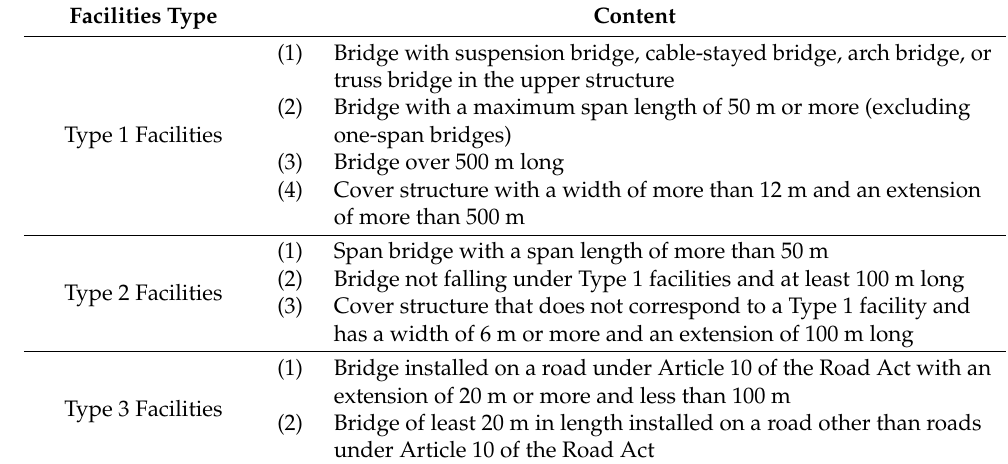
Table 1. Classification of facilities in Korea.